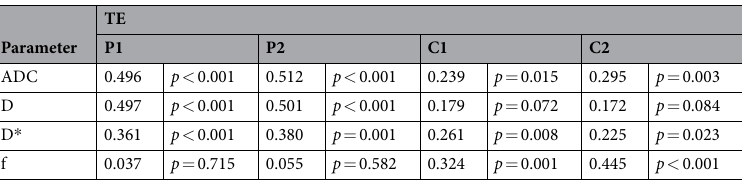
Table 4. The Spearman’s rho analysis between ADC, D, D * , and f and the TE value. Note: P peripheral zone; C central zone; 1 the measurement results for the first examination; 2 the measurement results for the second